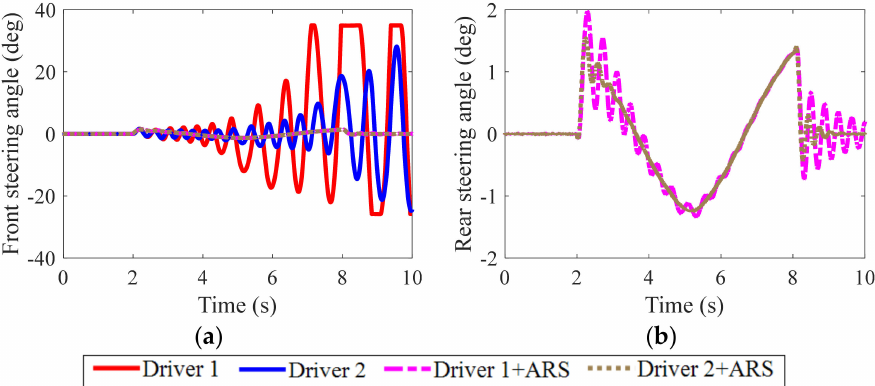
Figure 6. Active safety performances of vehicles in Case A: ( a ) lateral offset; ( b ) sideslip angle; ( c ) yaw rate: ( d ) roll angle.